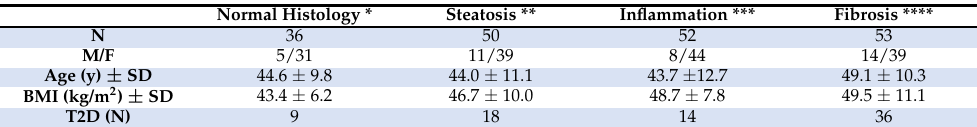
Table 1. Characteristics of study